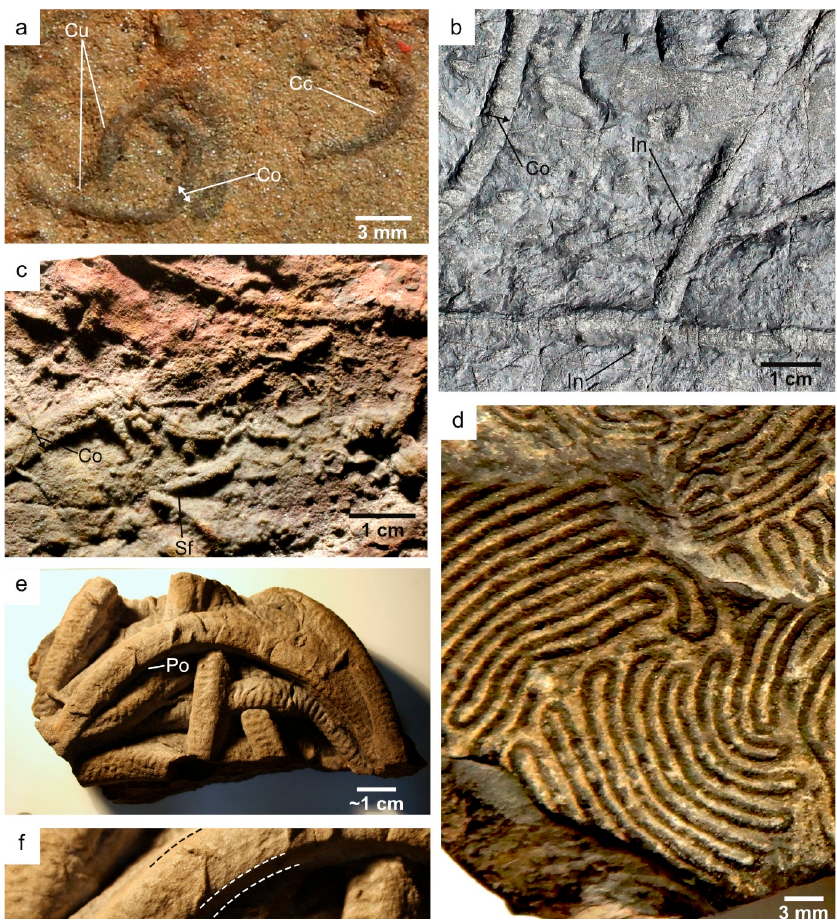
Figure 5. Ichnofossils and their salient features. ( a ) Fossil burrows ( Helminthoidichnites ) showing constant width (Co), curved morphology (Cu) and color contrast with the host rock (Cc). Upper Carboniferous of the Pramollo Basin, Italy-Austria [39,40]. ( b ) Fossil burrows ( Taenidium isp.) displaying constant width (Co) and intersections (In). Corte Pereiro section, Toca da Moura Complex, Ossa-Morena Zone in southern Portugal (Carboniferous: Mississipian). ( c ) Helminthoidichnites and Cruziana problematica displaying constant width (Co) and steep flanks (Sf). Ichnological Park of Penha Garcia, Portugal (Ordovician). ( d ) Nereites ( = Helminthoida ) irregularis showing constant width and thigmotaxis, i.e., a behaviour according to which an organism stays close to an existing entity. Piani di Creto, Italy (Cretaceous). Specimen 24175 / TF16 of the University of Genova. ( e ) Arthrophycus alleghaniensis displaying polygonal, squarirsh cross-section (Po). Maç ã o, Portugal (Lower Ordovician). Specimen 13,184 of the Geological Museum of Lisbon [44]. ( f ) Detail of the square cross-section (dashed lines) of Arthrophycus alleghaniensis. The magnified area is indicated by Po in Figure